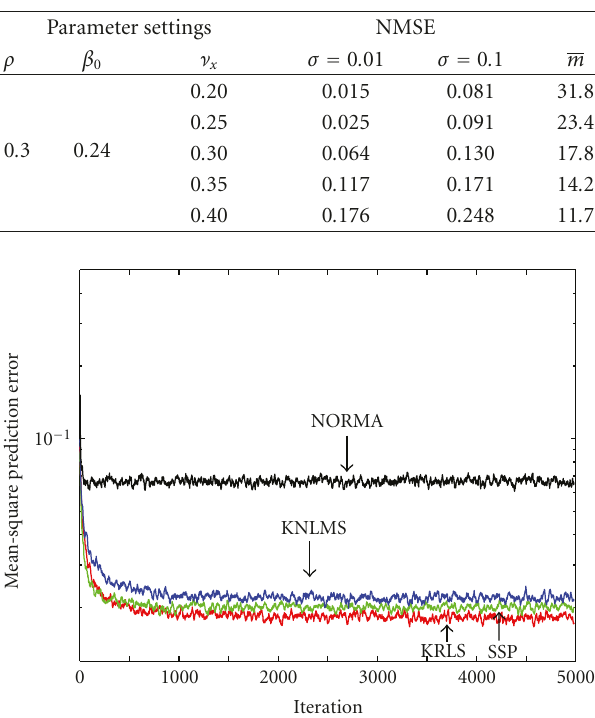
Table 2: Parameter settings, performance and model order as a function of the measurement noise level.